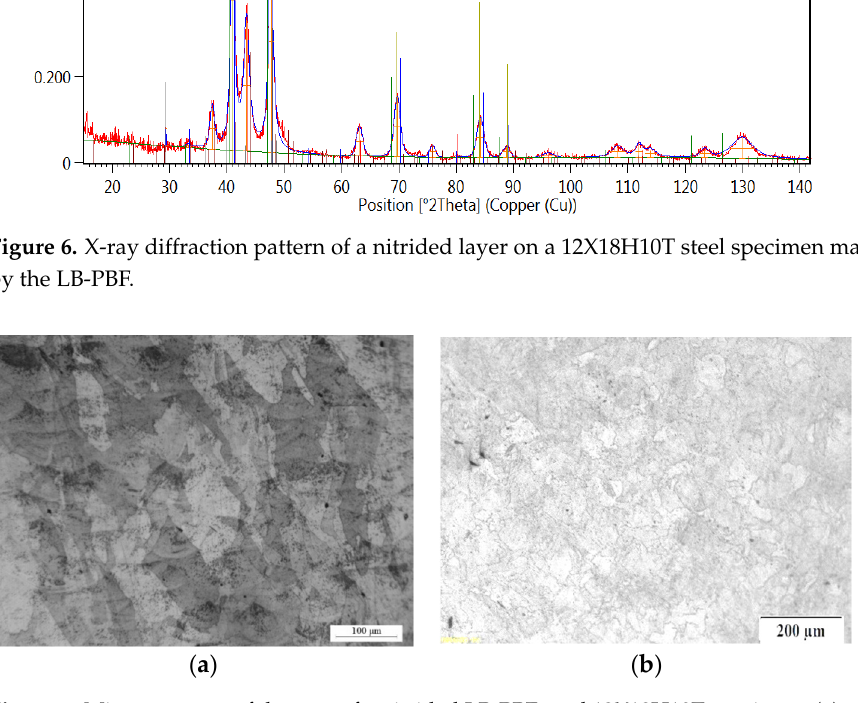
Figure 7. Microstructure of the core of a nitrided LB-PBF steel 12X18H10T specimen: ( a ) cross-section perpendicular to the direction of laser scanning and ( b ) longitudinal cross-section.